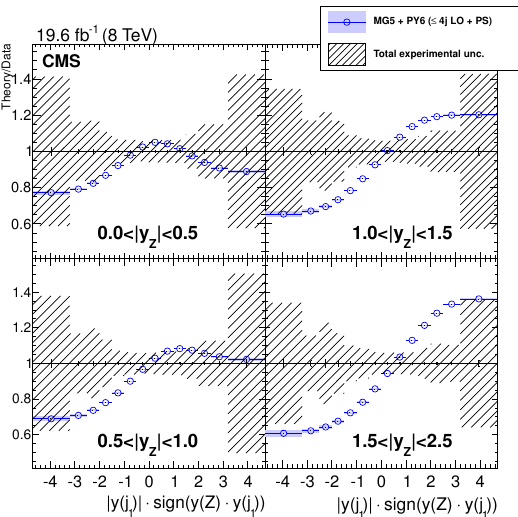
Figure 34 . Ratio to the measurement of the di(cid:11)erential cross section d 2 (cid:27)= d y (Z)d y (j with MadGraph 5 + pythia 6, with up to four jets at LO. The total experimental uncertainty is shown as a band around 1. Uncertainties in the predictions are shown on the ratio points and represent the statistical uncertainty alone.